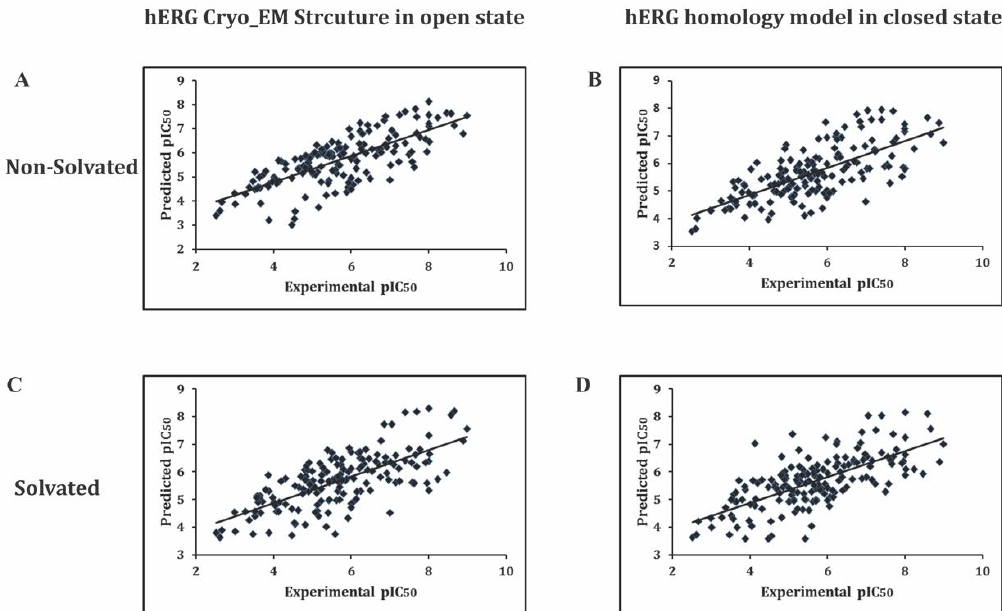
Figure 9. The plot of training set of actual versus observed prediction of ( A ) non-solvated-open state docked conformations and ( B ) non-solvated-closed state docked conformations. ( C ) Solvated-open state docked conformations and ( D ) solvated-closed state docked conformations.